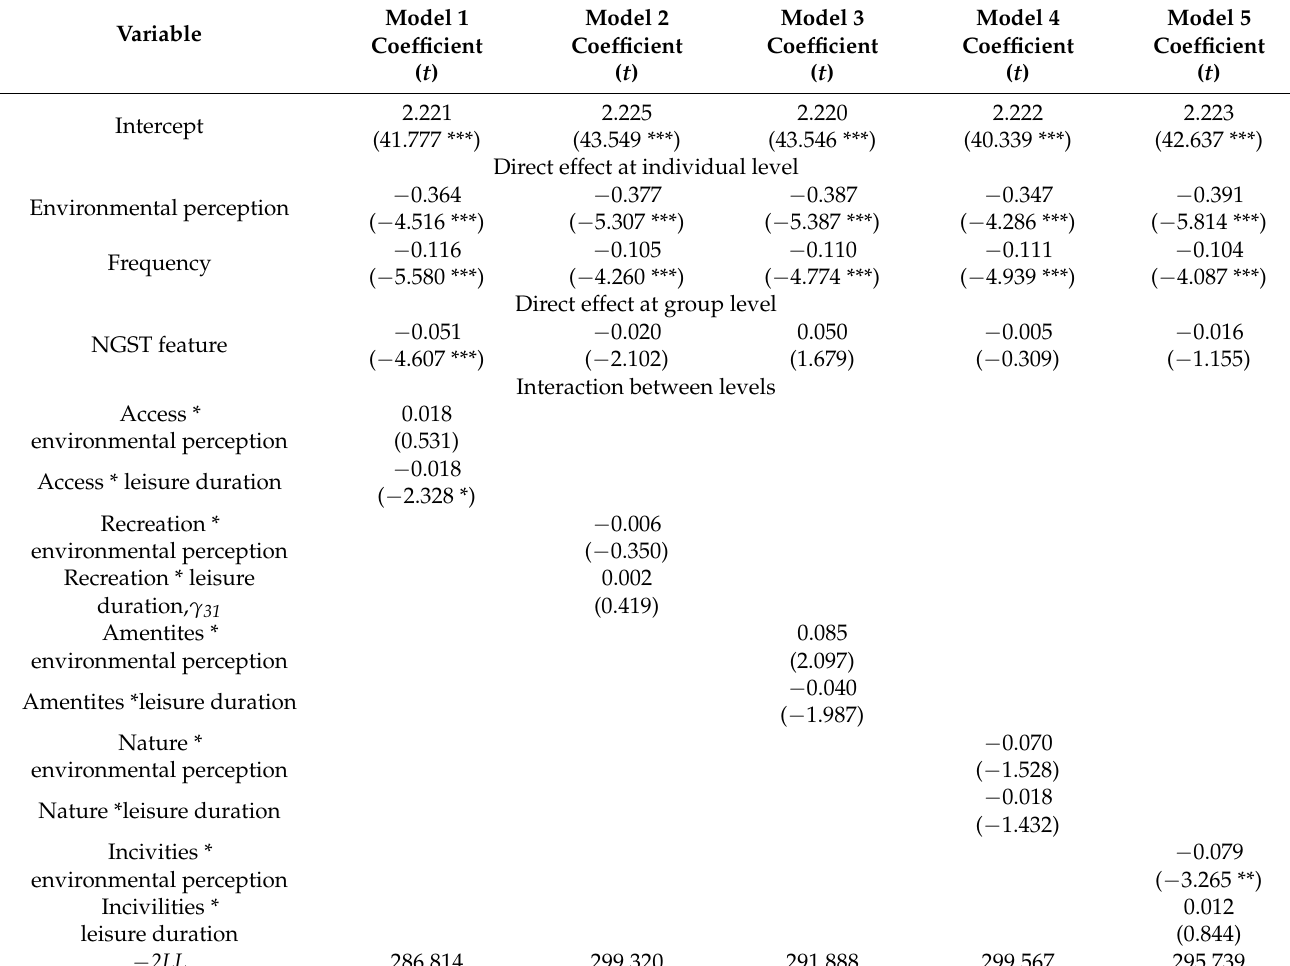
Table 7. Moderating effect of NGST for each feature of the examined model (depression as an